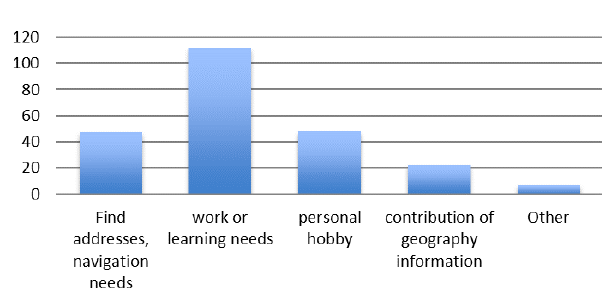
Figure 8. The purpose of using OSM